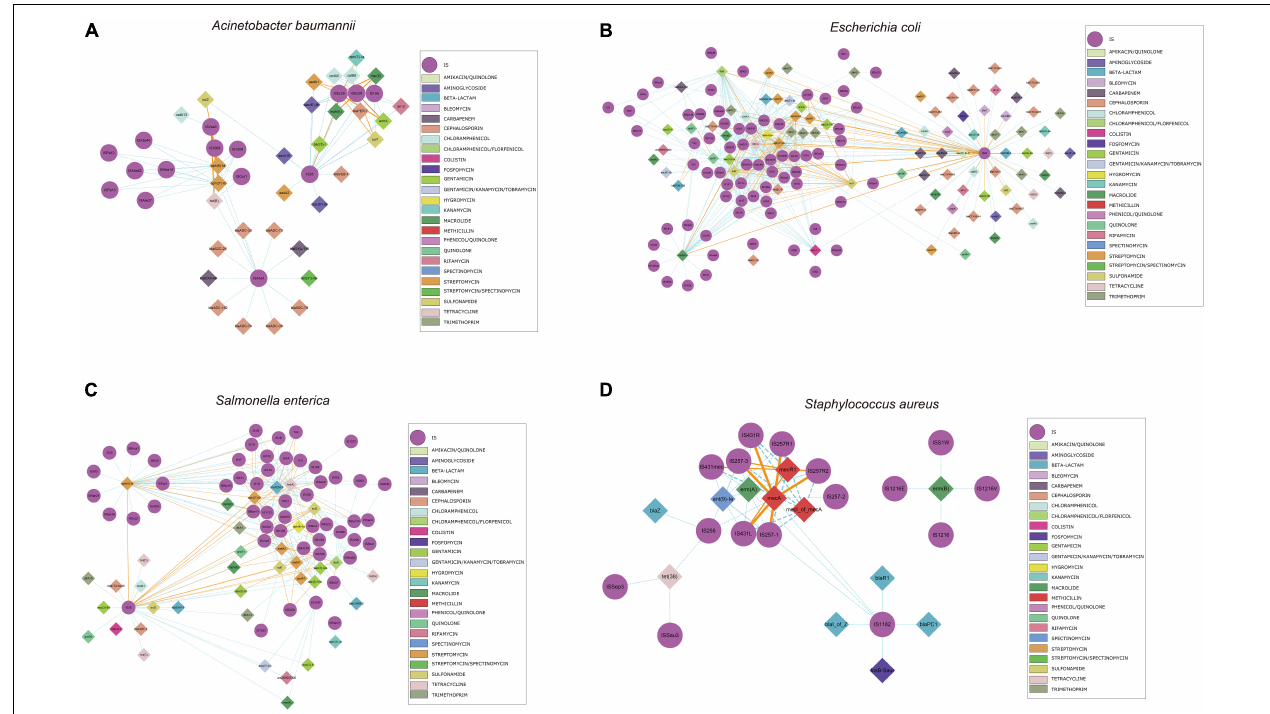
FIGURE 4 | Genomic proximity of antibiotic resistance genes (ARGs) and Insertion sequences (ISs) in four species: (A) A. baumannii , (B) E. coli , (C) S. enterica, and (D) S. aureus . ARGs and ISs pairs with a distance of less than 10 kb and frequency of occurrence no less than 10 were screened to construct the network. Diamond symbols are used to represent ARGs, circles for ISs. The solid line is the gene pair whose frequency is not less than 80% of the total number and labeled as orange, the dotted line represents the gene pair whose frequency is less than 80% of the total number and labeled as sky blue, and the width of the line indicates the frequency. Different colors are assigned to the antibiotics corresponding to the drug-resistant genes, the insertion sequences are displayed in gray.